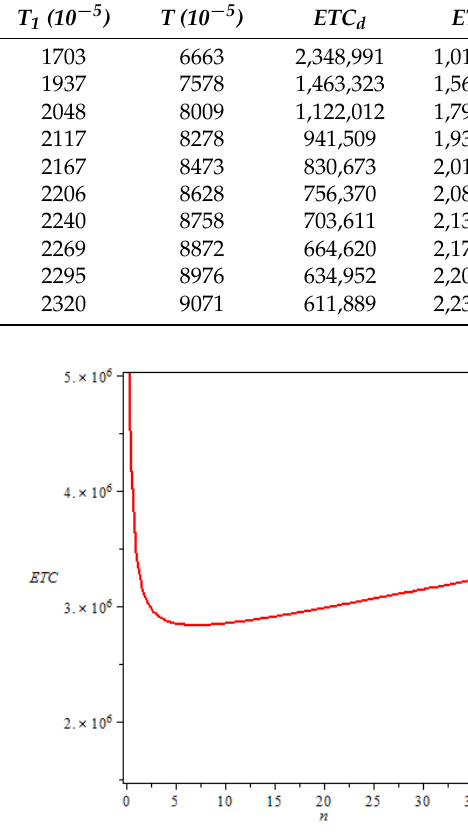
Figure 8. Graphical representation of expected total cost ( ETC ) for a fixed n in Model 1.